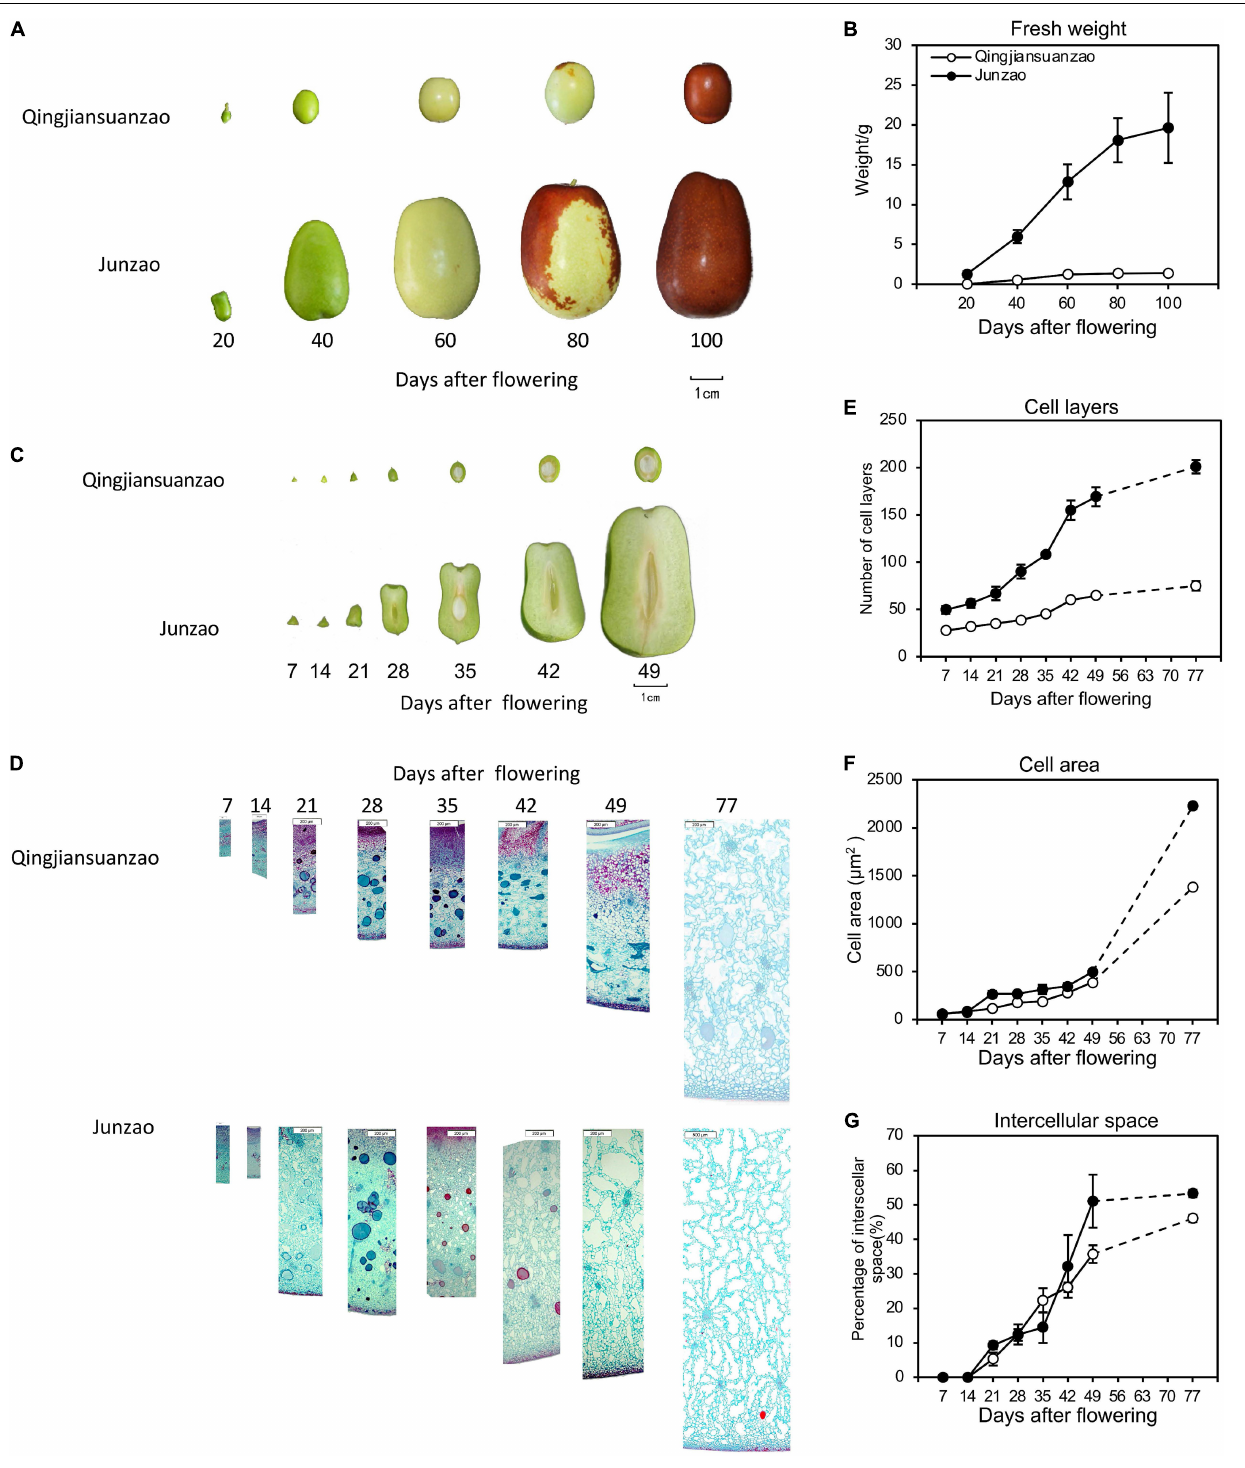
FIGURE 1 | The fruit growth pattern of cultivated jujube ‘Junzao’ and wild jujube ‘Qingjiansuanzao’. (A) Fruit ripening progress of ‘Junzao’ and ‘Qingjiansuanzao’ represented by five stages at 20, 40, 60,80, and 100 days after flowering (DAF); (B) Fruit fresh weight increase patterns; (C) Cross-section of fruits sampled weekly from 7 DAF to 49 DAF; (D) Anatomy observation of the mesocarp from 7 to 49 DAF and 77 DAF; (E–G) indicate the change in the pattern of the cell layer, cell area, and intercellular space of the mesocarp from 7 to 49 DAF weekly and at 77 DAF. Values are means of three biological replicates ± SD.